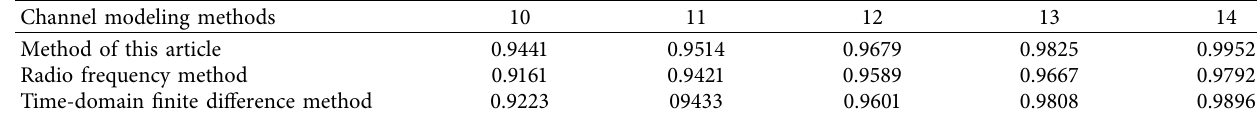
Figure 16: Network coverage of 14 nodes: (a) before optimization and (b) after optimization. Table 2: Comparison of coverage rates of different algorithms with different number of